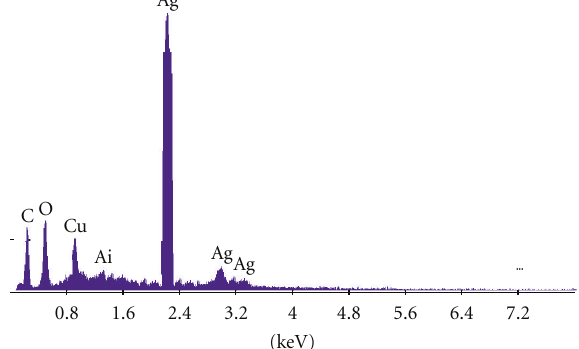
Figure 4: Energy dispersive X-ray spectrum (EDAX) of metallic